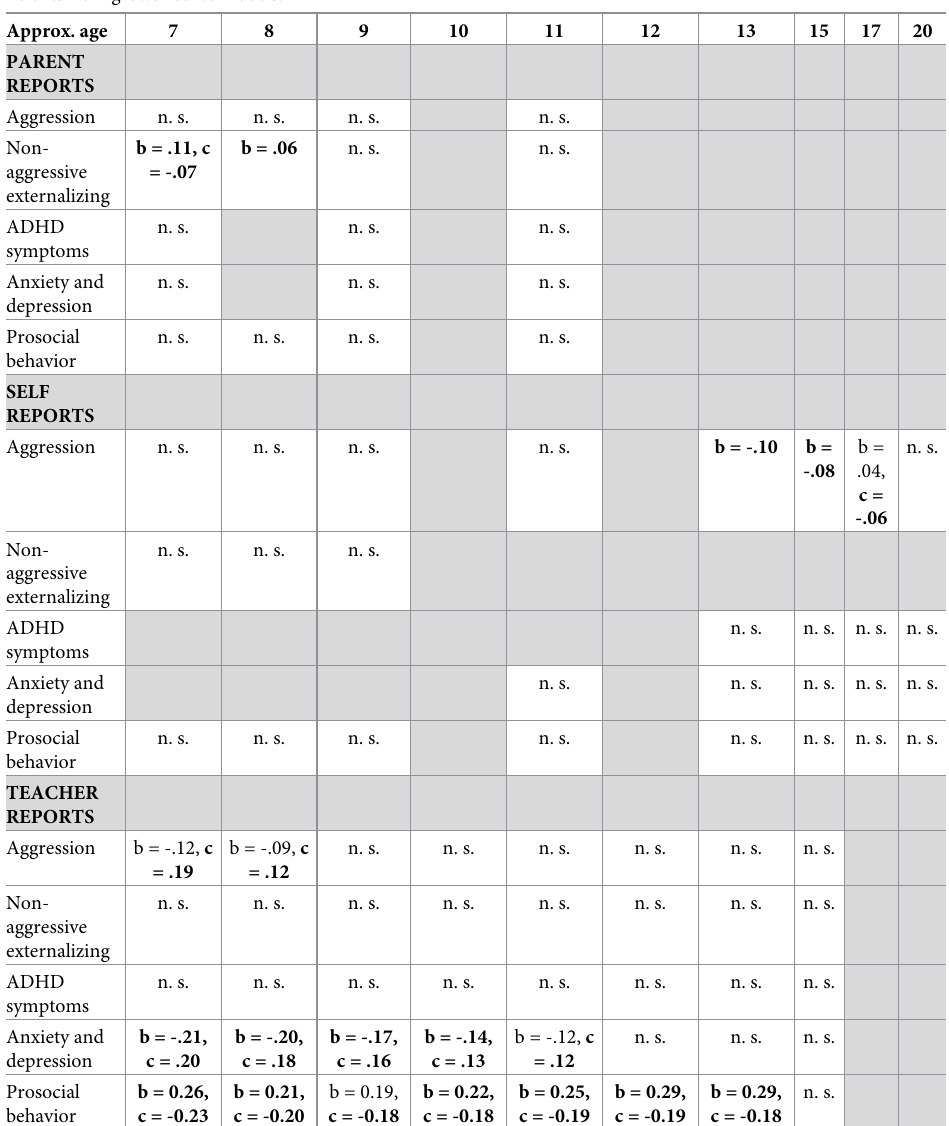
Table 4. Relations between amount of time spent in a playgroup and social behavior by age. Unstandardized coef- ficients from growth curve